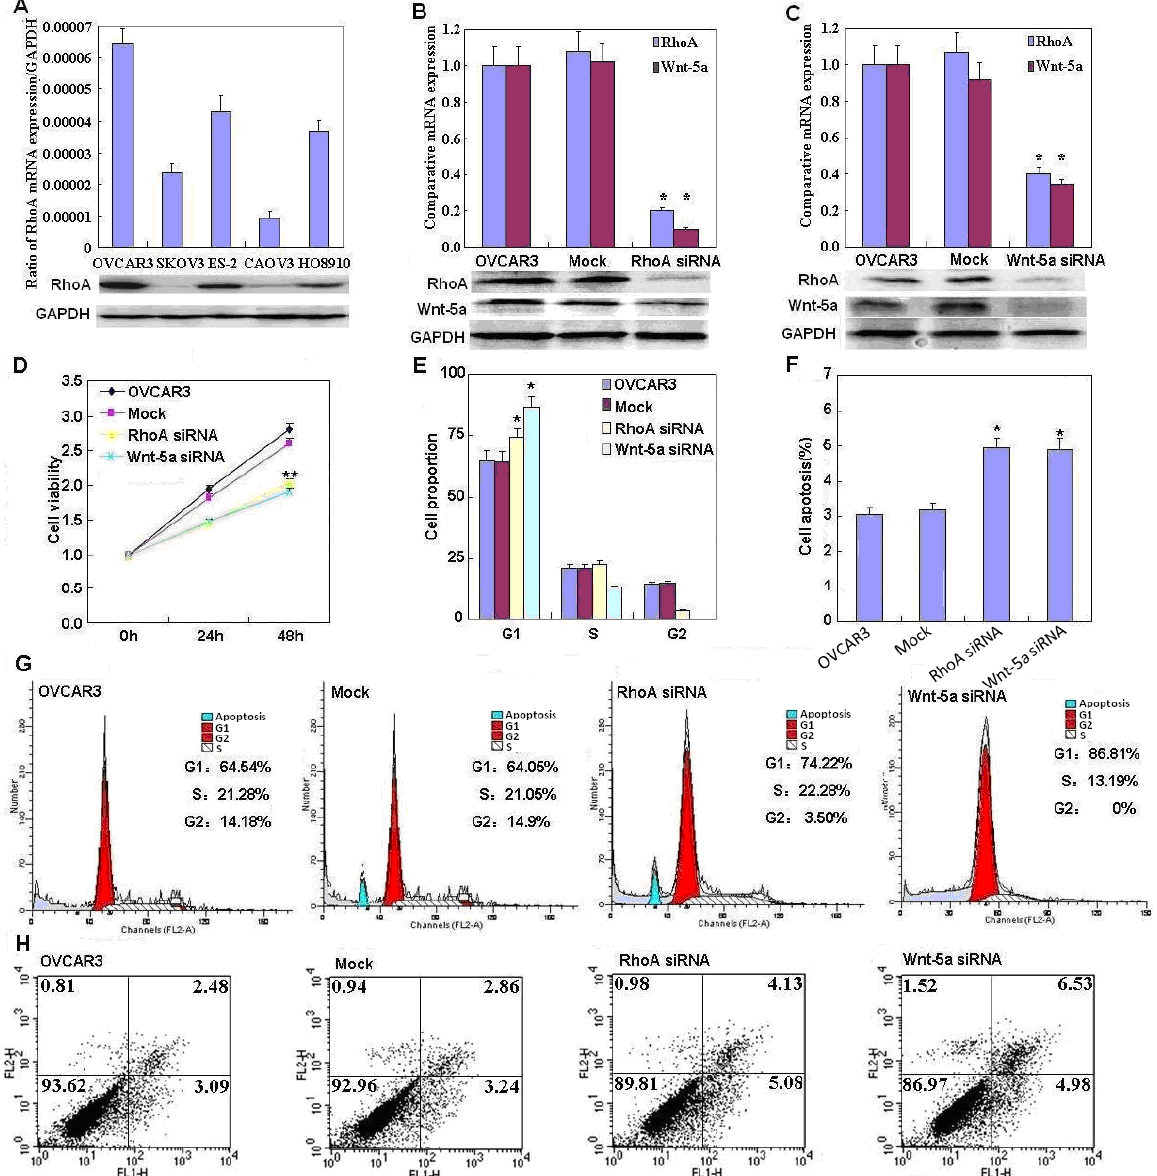
Figure 2. Effects of RhoA or Wnt-5a knockdown on mRNA and protein expression, cell proliferation, cell cycle, and apoptosis of ovarian carcinoma cells. ( A ) OVCAR3 cells were used for RhoA siRNA transfection because RhoA mRNA and protein expression was highest in this cell line; RhoA siRNA ( B ) or Wnt-5a siRNA transfection ( C ) significantly reduced RhoA and Wnt-5a expression in OVCAR3 cells compared to negative control (NC) or mock-transfected cells. OVCAR3 cells transfected with RhoA siRNA or Wnt-5a siRNA exhibited significantly reduced cell viability ( D ) in comparison with NC and mock-transfected cells; ( E , G ) Significantly increased G arrest in OVCAR3 cells 1 transfected with RhoA siRNA or Wnt-5a siRNA in comparison with NC and mock-transfected cells; and ( F , H ) Significantly increased apoptosis in OVCAR3 cells transfected with RhoA siRNA or Wnt-5a siRNA in comparison with NC and mock-transfected cells. * p < 0.05. Results are representative of three separate experiments; data are expressed as the mean ± standard